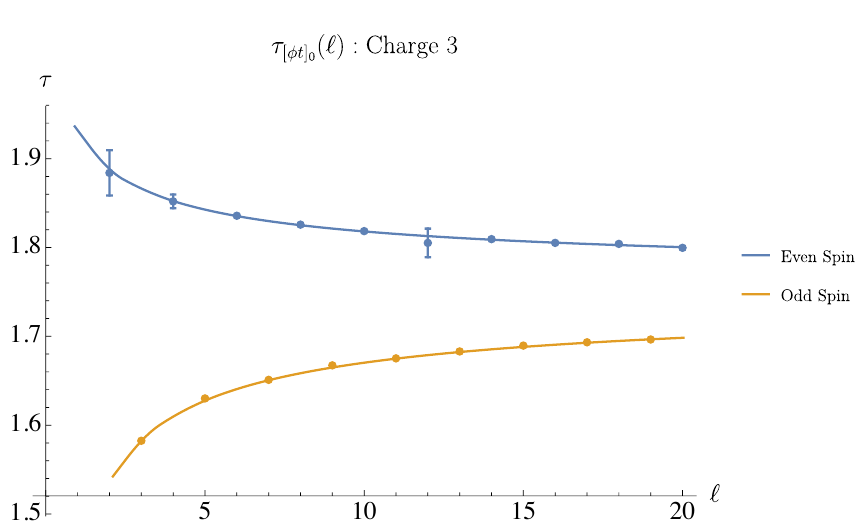
� �� �� Figure 5 . Analytic and numerical predictions for the spectrum of the [ (cid:30)t ] 3 The upper (blue) curve represents even spin operators, while the lower (orange) curve represents odd-spin operators.